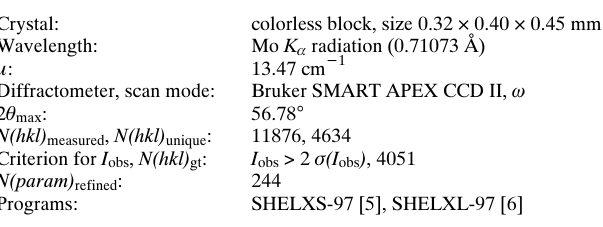
Table 1. Data collection and